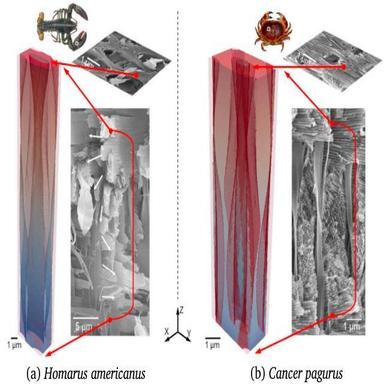
Representative Volume Elements (RVEs) and corresponding scanning electron micrographs in cross-sectional and transverse orientations of the endocuticle.